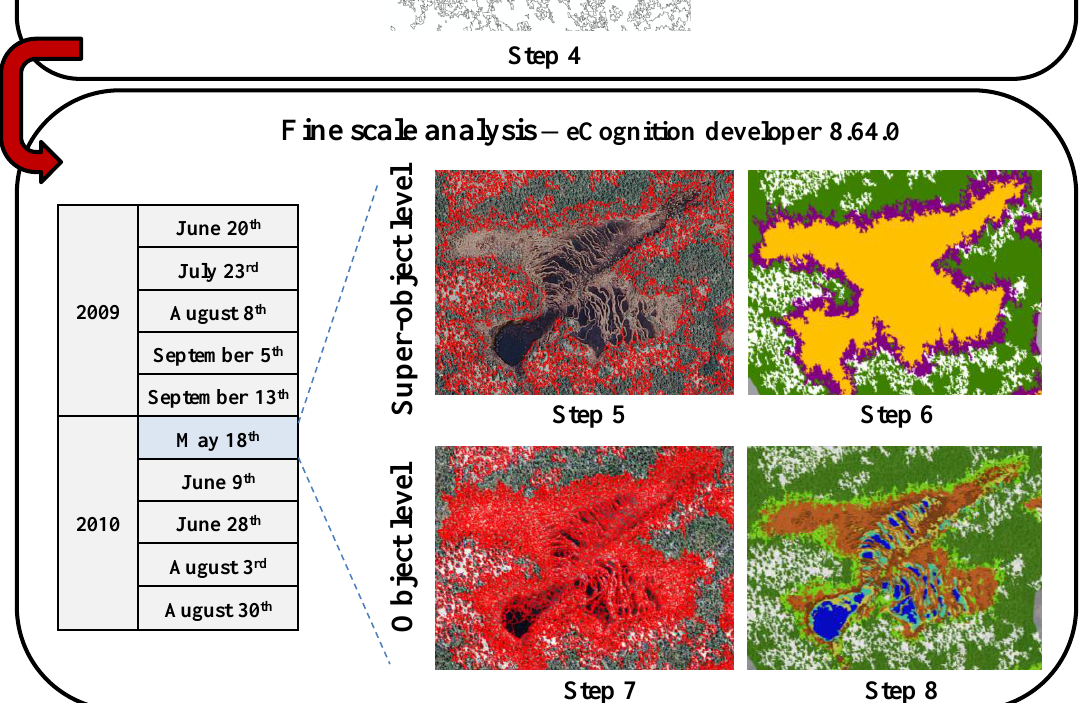
Coarse scale analysis – eCognition developer